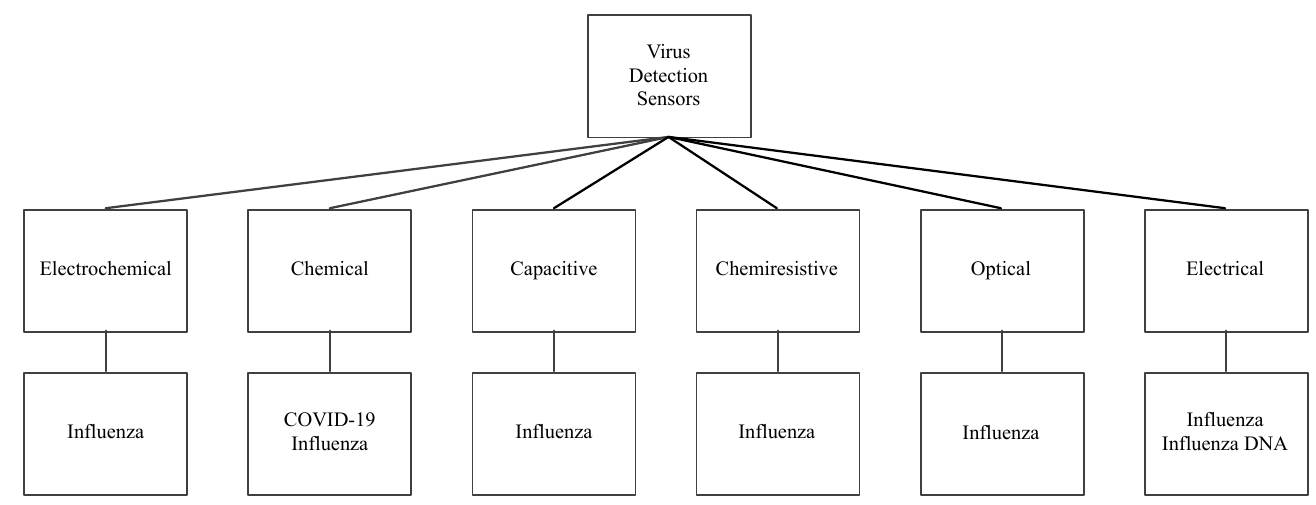
Figure 15. Virus sensors and their working principles.